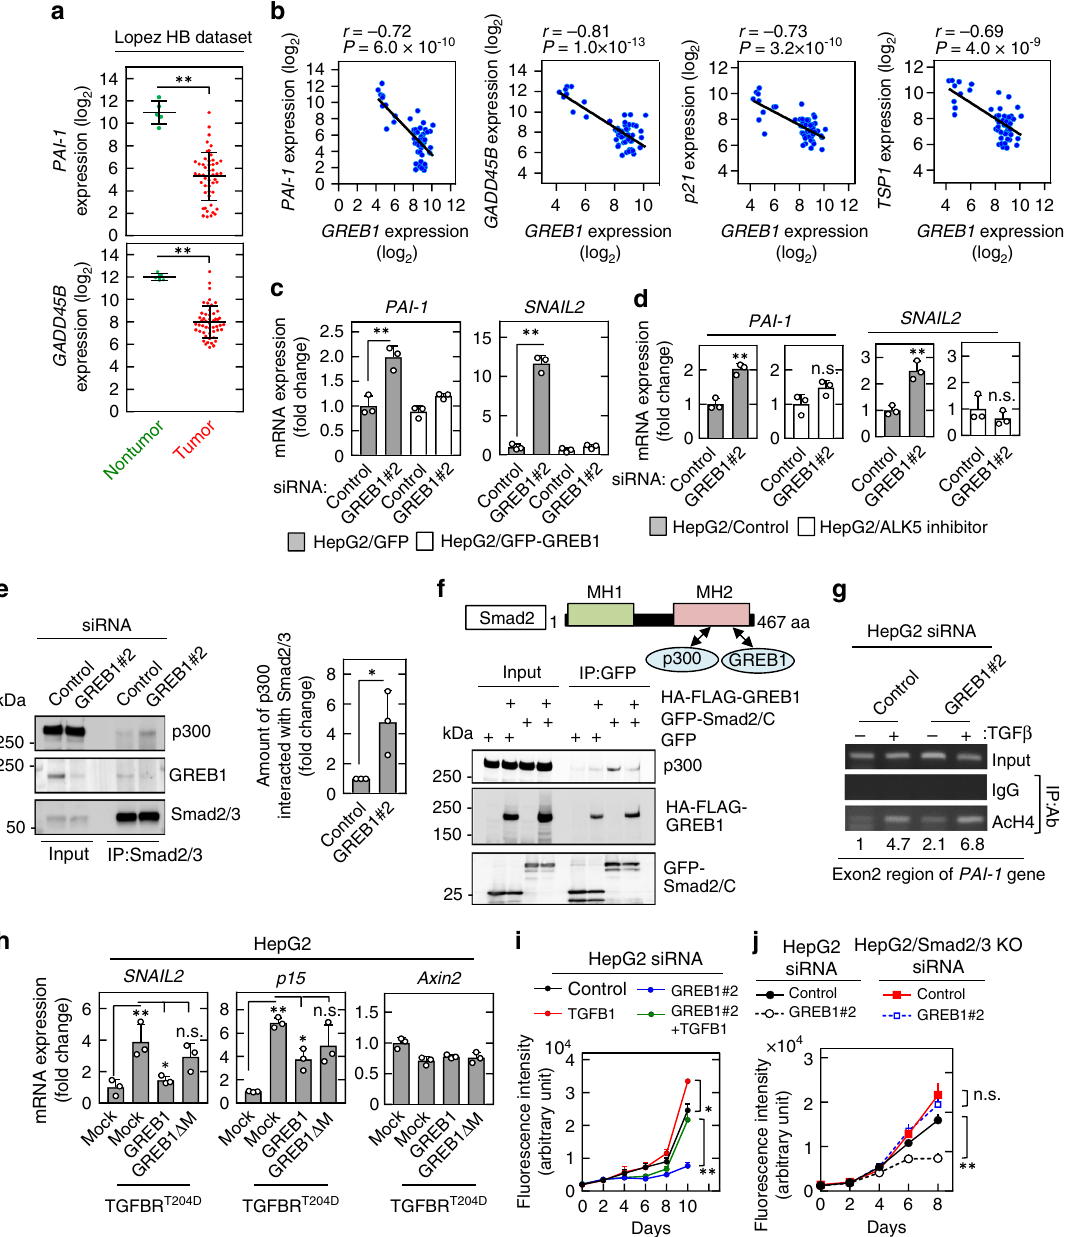
Fig. 4 GREB1 inhibits TGF β signaling. a Expression of PAI-1 and GADD45B gene, which were obtained from dataset of HB, was analyzed. The results shown are scatter plots with means ± SD. ** P < 0.01, t test. b Scatter plots showing correlation between target genes of TGF β signaling ( Y -axis) and GREB1 gene expression ( X -axis) were obtained from the dataset of HB. r value and P value were calculated with GraphPad Prism 7. c HepG2 cells stably expressing GFP or GFP-GREB1 was transfected with control or GREB1 #2 siRNA. Real-time PCR analyses for indicated mRNA expression were performed. d HepG2 cells were transfected with control or GREB1 #2 siRNA with or without ALK5 inhibitor and real-time PCR experiments for indicated mRNA expression were performed. ** P < 0.01, t test. e Lysates of HepG2 cells transfected with control or GREB1 #2 siRNA were immunoprecipitated with anti-Smad2/3 antibody. The immunoprecipitates were probed with the indicated antibodies. Relative band intensities of p300 coprecipitated with Smad2/3 were quanti fi ed. ** P < 0.01, t test. f The binding region of Smad2 for p300 and GREB1 is shown. Lysates of HepG2 cells expressing the indicated proteins were immunoprecipitated with anti-GFP antibody. The immunoprecipitates were probed with the indicated antibodies. g Chromatin from HepG2 cells transfected with control or GREB1 #2 siRNA and untreated or treated with 10 ng/ml TGF β 1 for 30 min was immunoprecipitated with IgG or anti-acH4 antibody. The exon2 region of the precipitated PAI-1 gene was analyzed by PCR with region-speci fi c primers. h HepG2 cells were transfected with the indicated plasmids. Real-time PCR experiments for indicated mRNA expression were performed. ** P < 0.01; * P < 0.05, ANOVA and post hoc test. i HepG2 cells were transfected with the indicated siRNAs, and cultured for the indicated numbers of days. Relative cell numbers were quanti fi ed using the Cyquant assay. ** P < 0.01, ANOVA and post hoc test. j Control or Smad2/3 KO HepG2 cells were transfected with control or GREB1 #2 siRNA and cultured for the indicated numbers of days. Relative cell numbers were quanti fi ed using the Cyquant assay. n.s., not signi fi cant. ** P < 0.01; * P < 0.05, ANOVA and